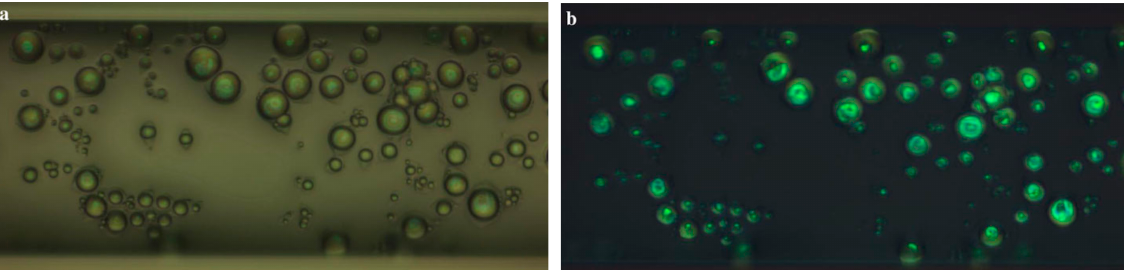
Figure 10. TLC particles in a microchannel with water as the working fluid, ( a ) at standard illumi- nation, and ( b ) with circular polarization filtering, from the work of Basson and Pottebaum [ 77 ] . Reprinted by permission from Ref. [ 77 ] , Experiment in Fluids, Copyright © 2022 Springer-Verlag.